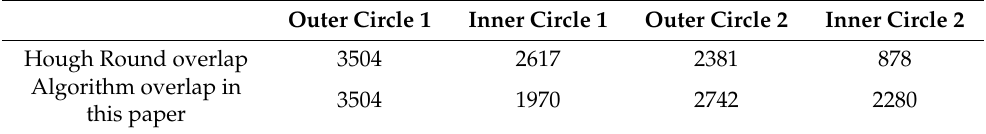
Table 2. Pixel consistency comparison.